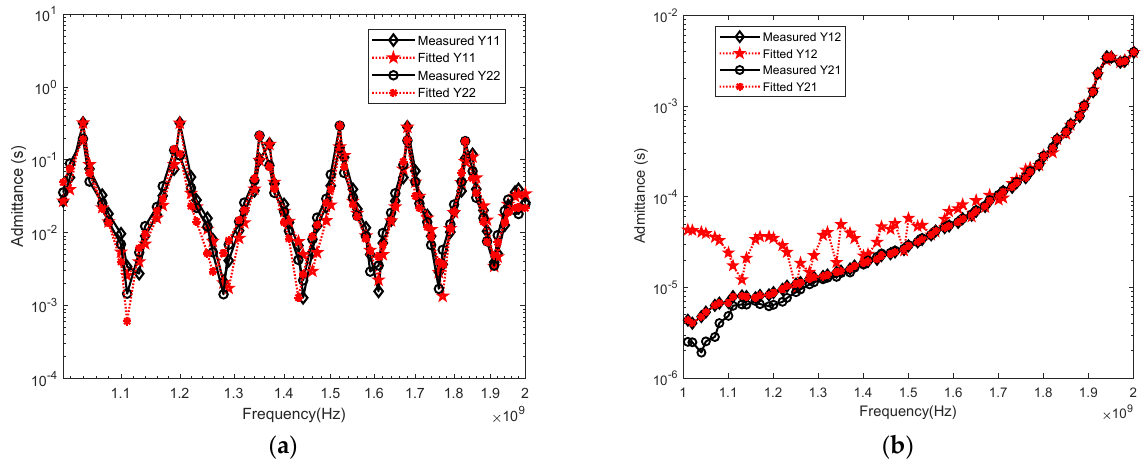
Figure 14. Comparison of Measured Admittance and Fitted results: ( a ) Y11 and Y22; ( b ) Y12 and Y21.